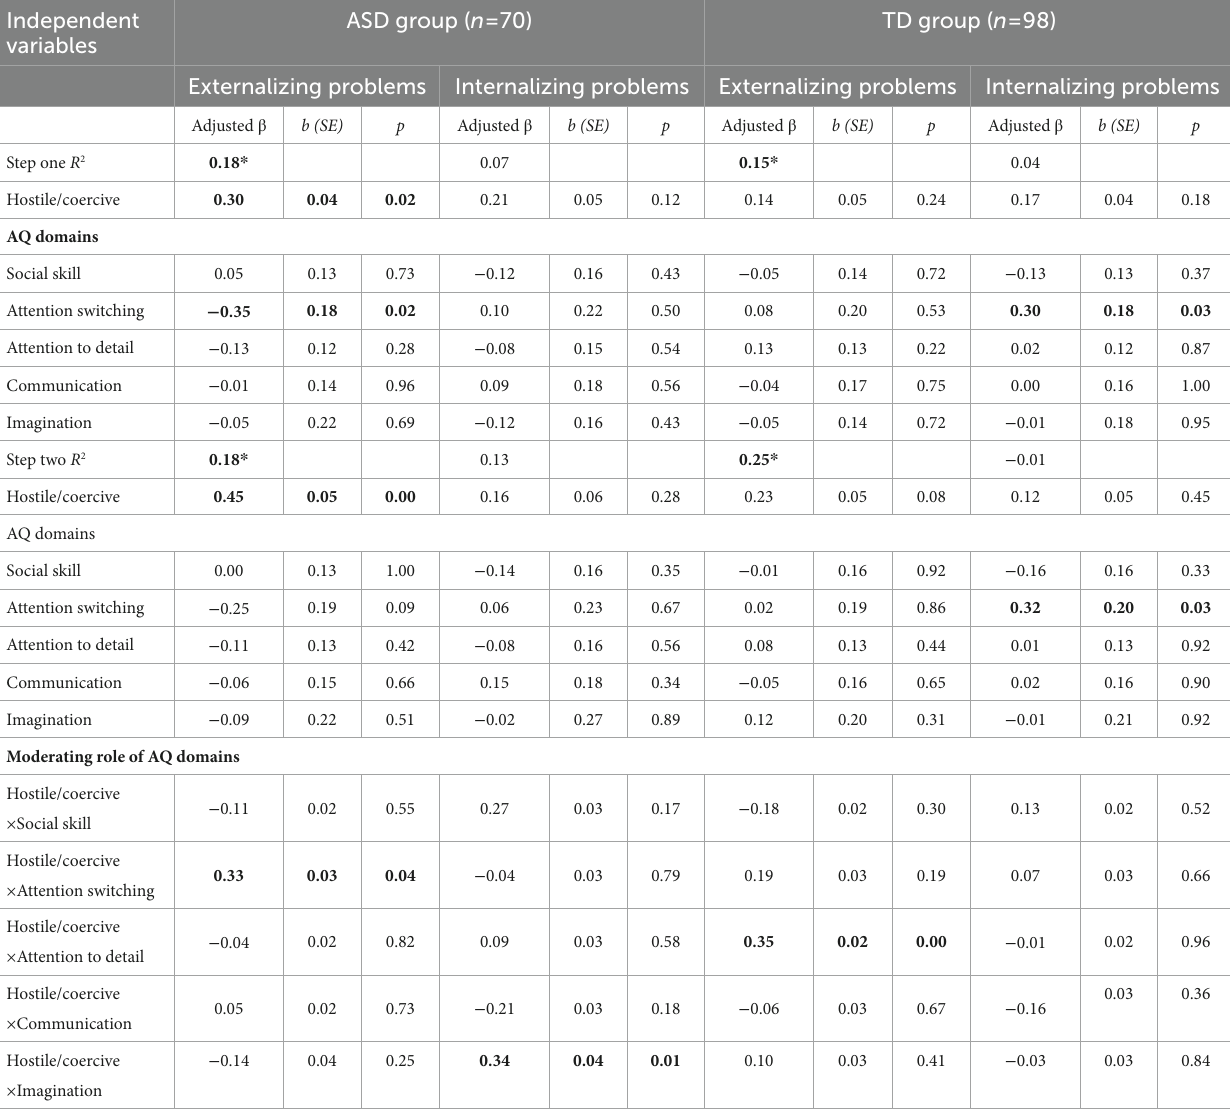
TABLE 2 Moderated multiple regression model of the hostile/coercive parenting behavior on behavior problems in children with ASD and TD. Independent